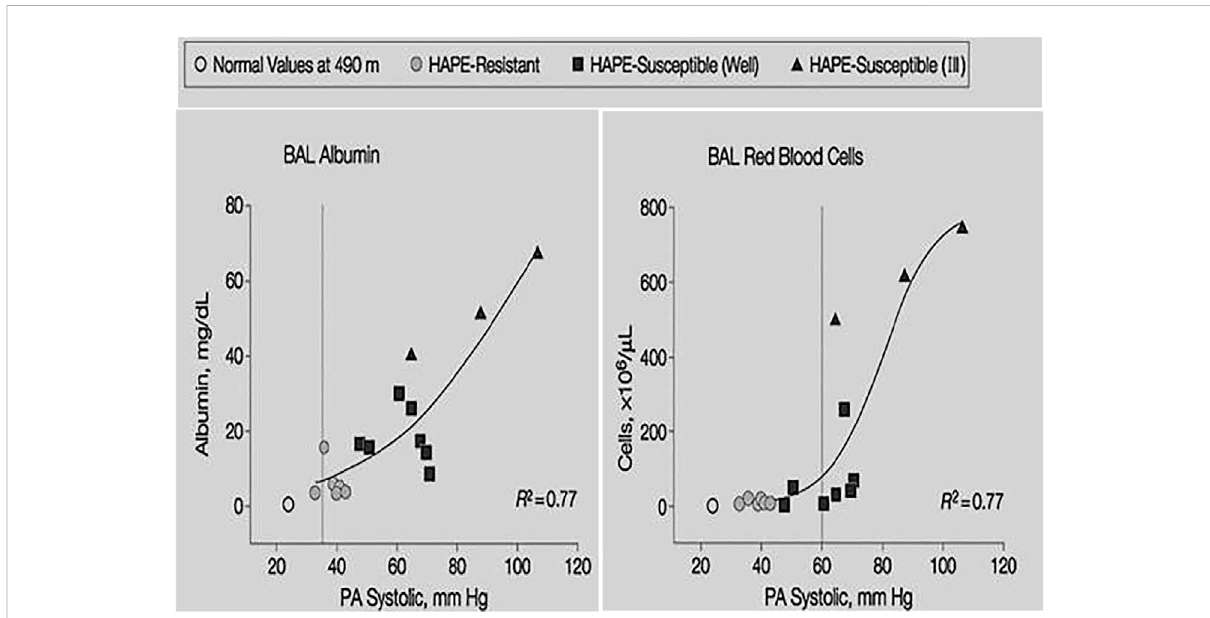
FIGURE 5 Individual BAL red cell count and albumin concentration plotted against systolic pulmonary artery pressure at 4,559 m. Shaded circles indicate values of HAPE resistant controls, fi lled squares indicate HAPE-susceptible subjects without HAPE and fi lled triangles indicate HAPE-susceptible subjectswithHAPE.DatatakenfromSwenson,E.R.,Maggiorini,M.,Mongovin,S.,Gibbs,J.S.,Greve,I.,Mairbaurl,H.,Bartsch,P.2002.Pathogenesisof high-altitude pulmonary edema: in fl ammation is not an etiologic factor. Jama, 287, 2228 –